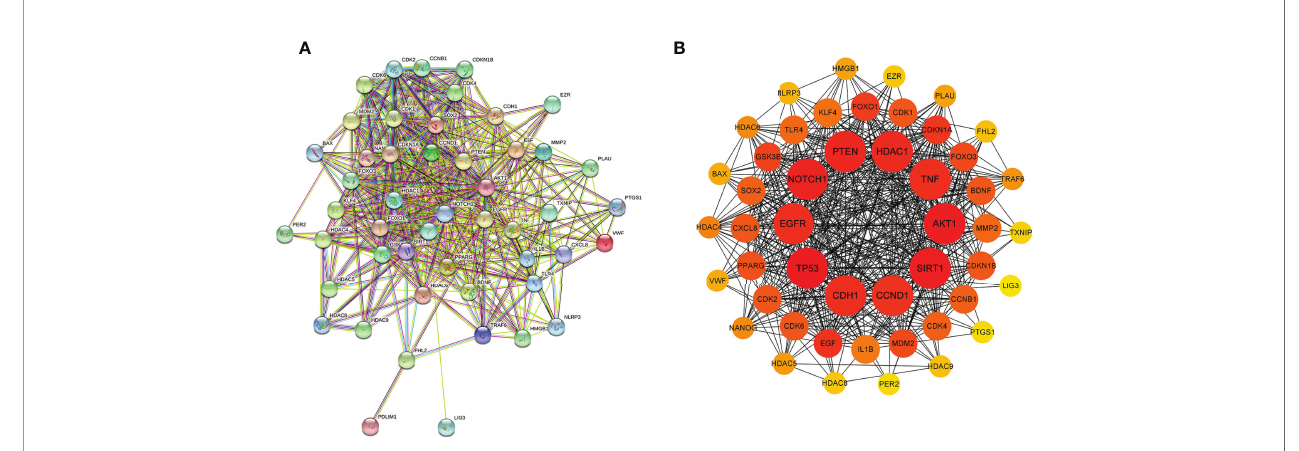
FIGURE 3 | Protein-protein interaction (PPI) network of the 51 intersectional genes was analyzed by STRING database (A) and the hub targets network including the top 10 targets were constructed by cytoHubba plug-in (B) . In the hub targets network, the larger the node and the redder the color represent the stronger the interaction degree.